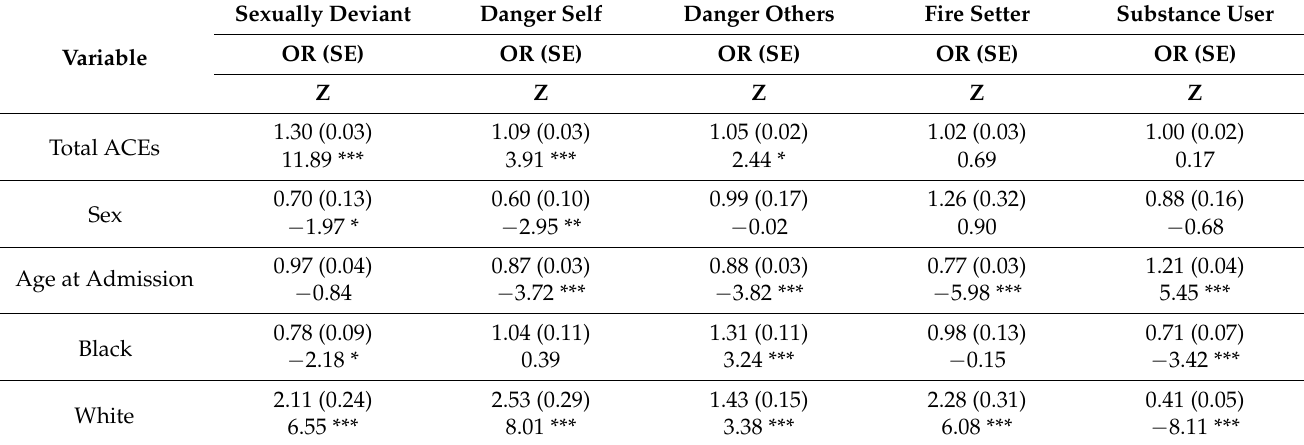
Table 2. Logistic Regression Models for Forensic Typologies for Total ACEs with